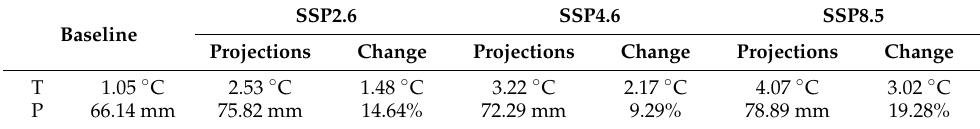
Table 3. Precipitation (P) and temperature (T) during the snowmelt runoff period from 2025 to 2054. SSP2.6 SSP4.6 SSP8.5 Baseline Projections Change Projections Change Projections